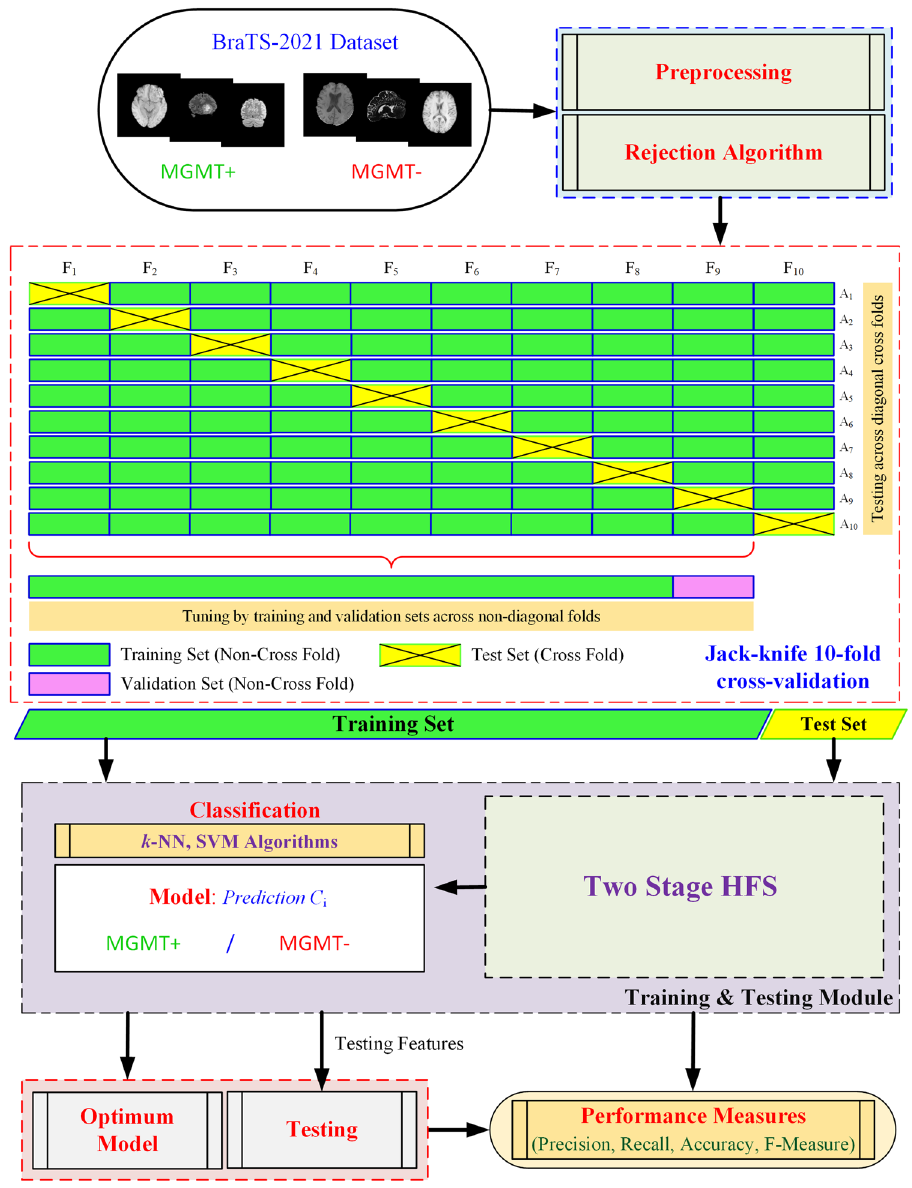
Figure 1. The proposed MGMT promoter methylation prediction (MGMT-PMP) system based on DLRFE forming a two-stage